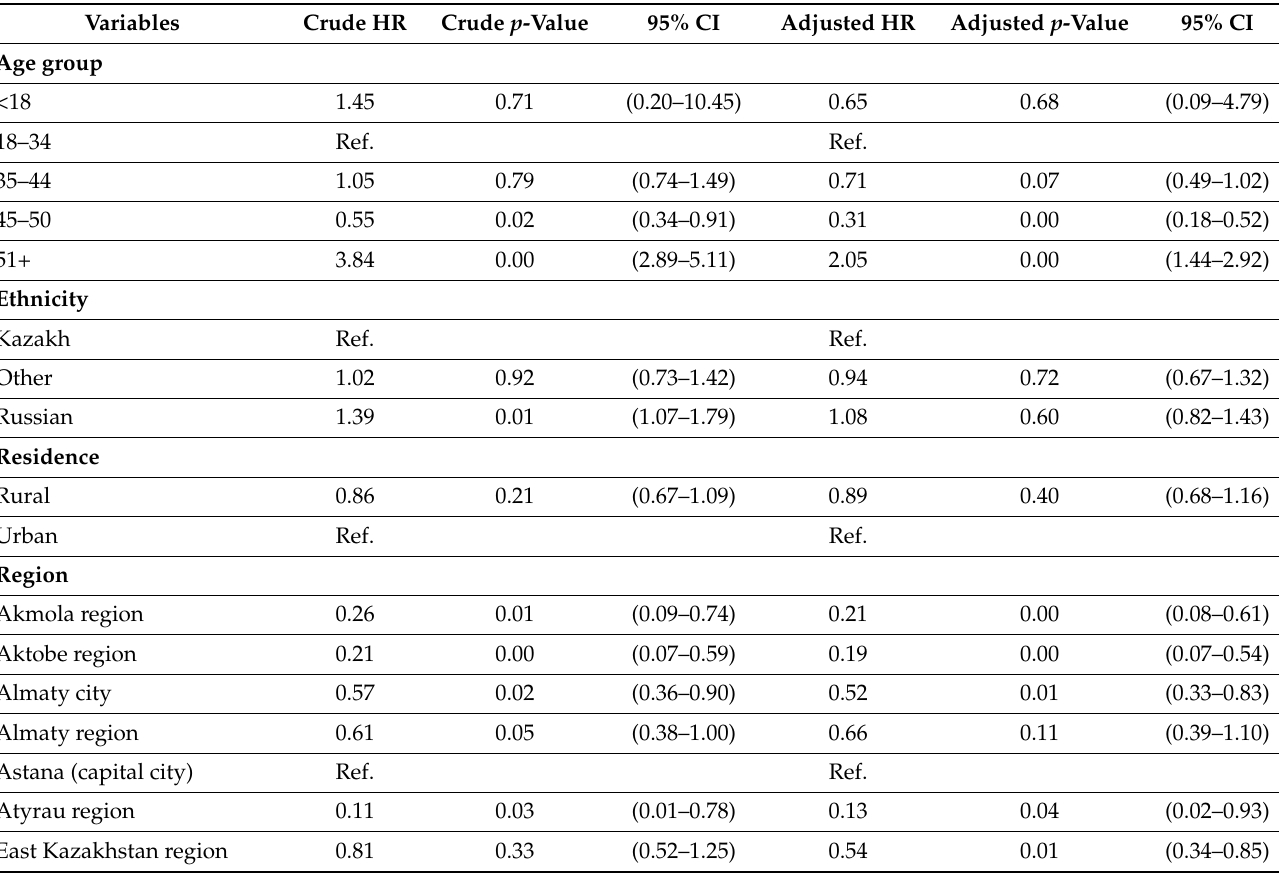
Table 4. Crude and adjusted Cox regression model with survival hazard